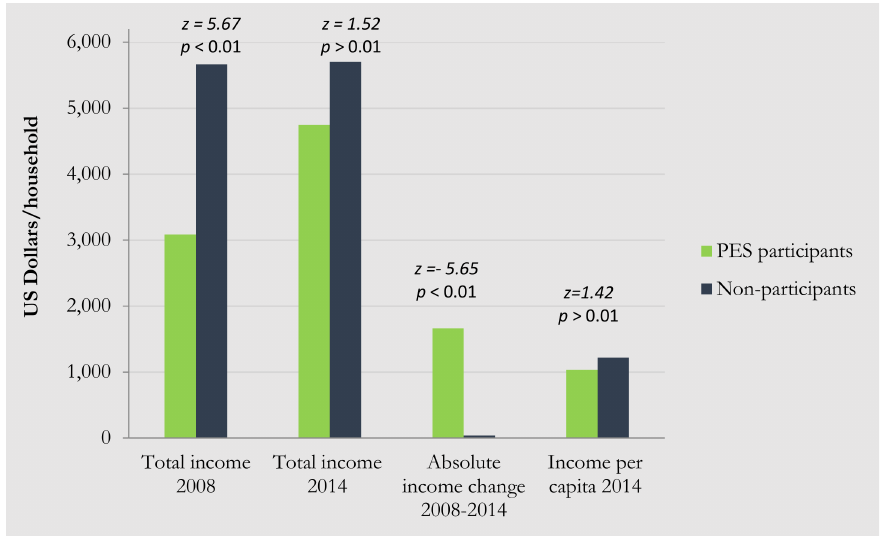
Fig 2. Comparison of changes in gross income of PES participants and